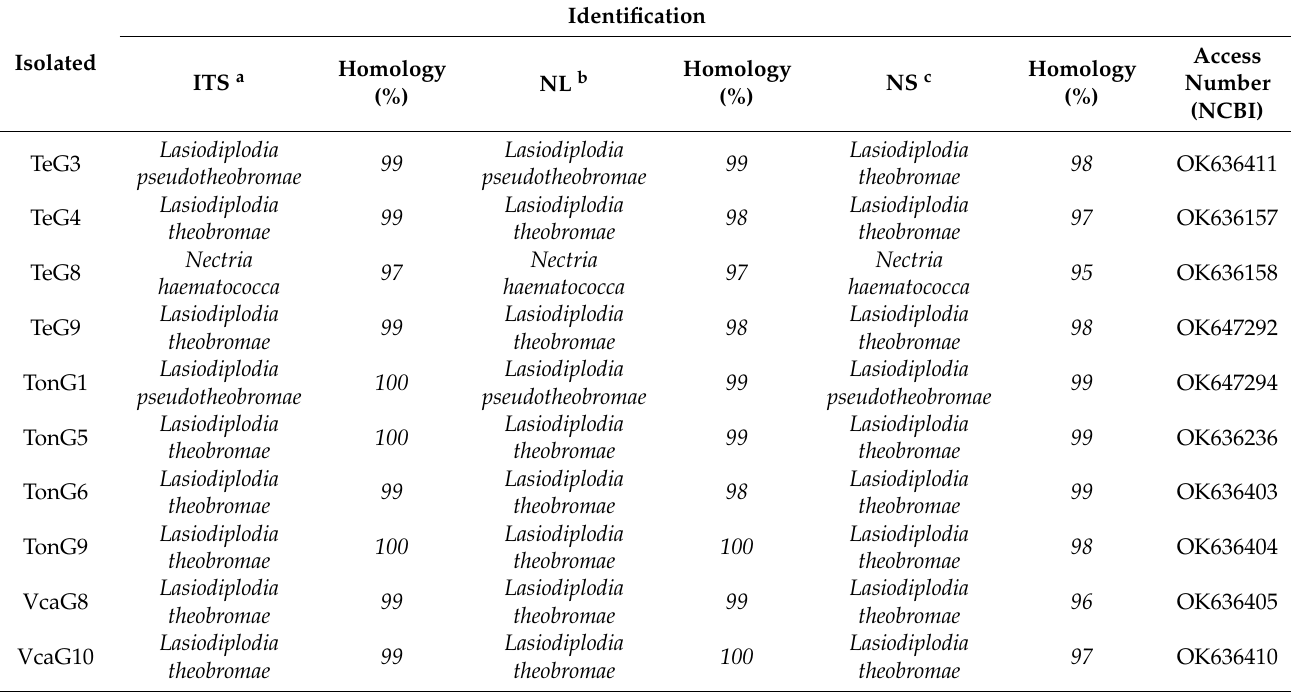
Table 2. Molecular identification of the most pathogenic fungi to soursop